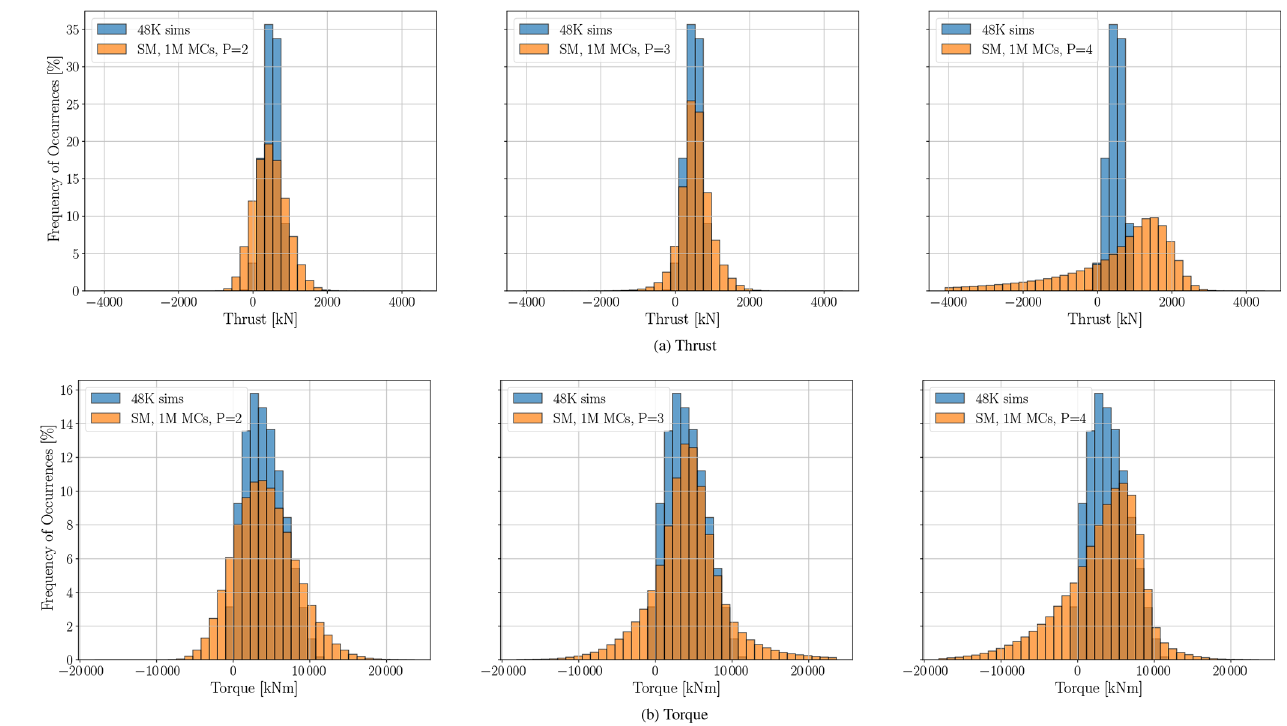
Figure 8. Thrust and torque surrogate models based on SGQ with 1 million MCSs vs. the reference case histogram.